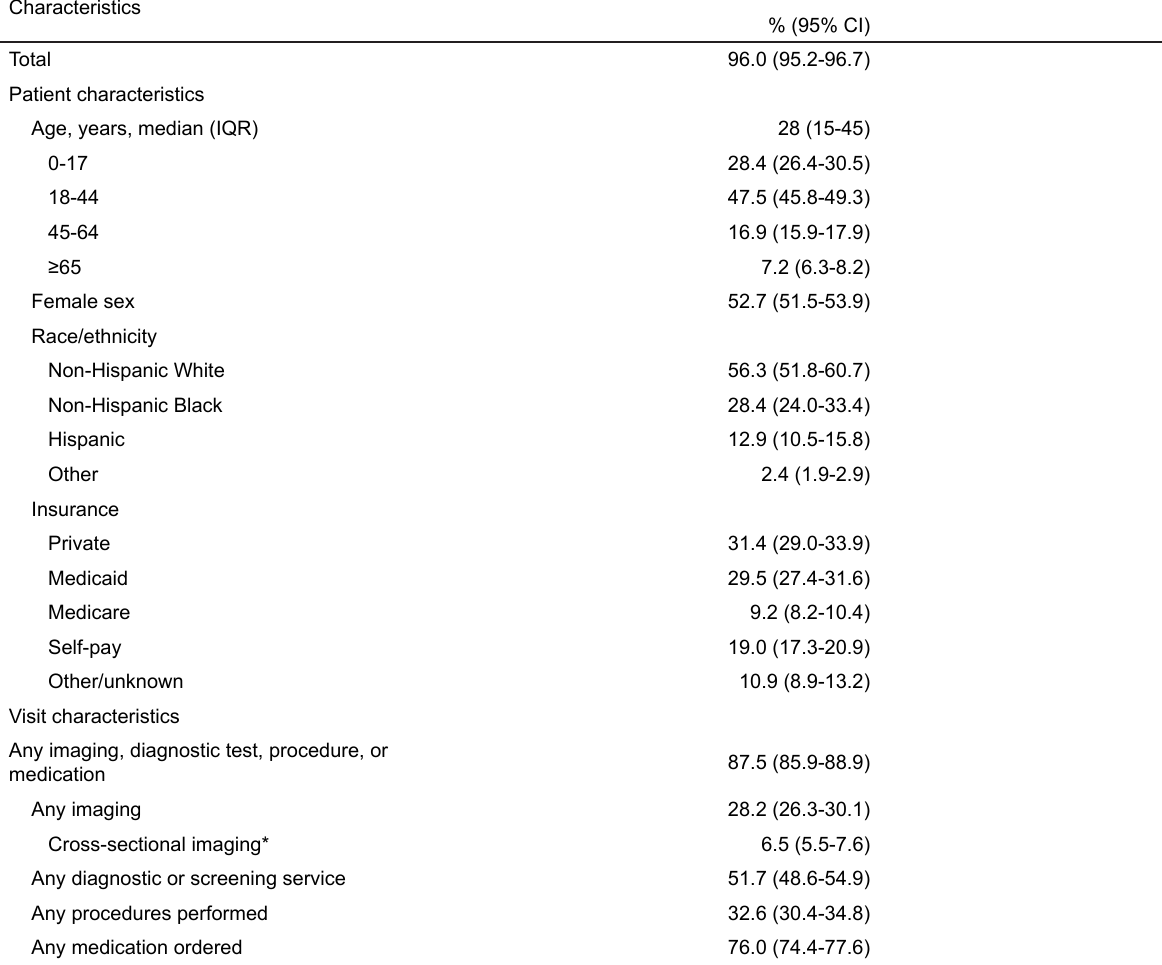
Table 3. Comparison of non-urgent emergency department (ED) visits that did and did not result in hospital admission.